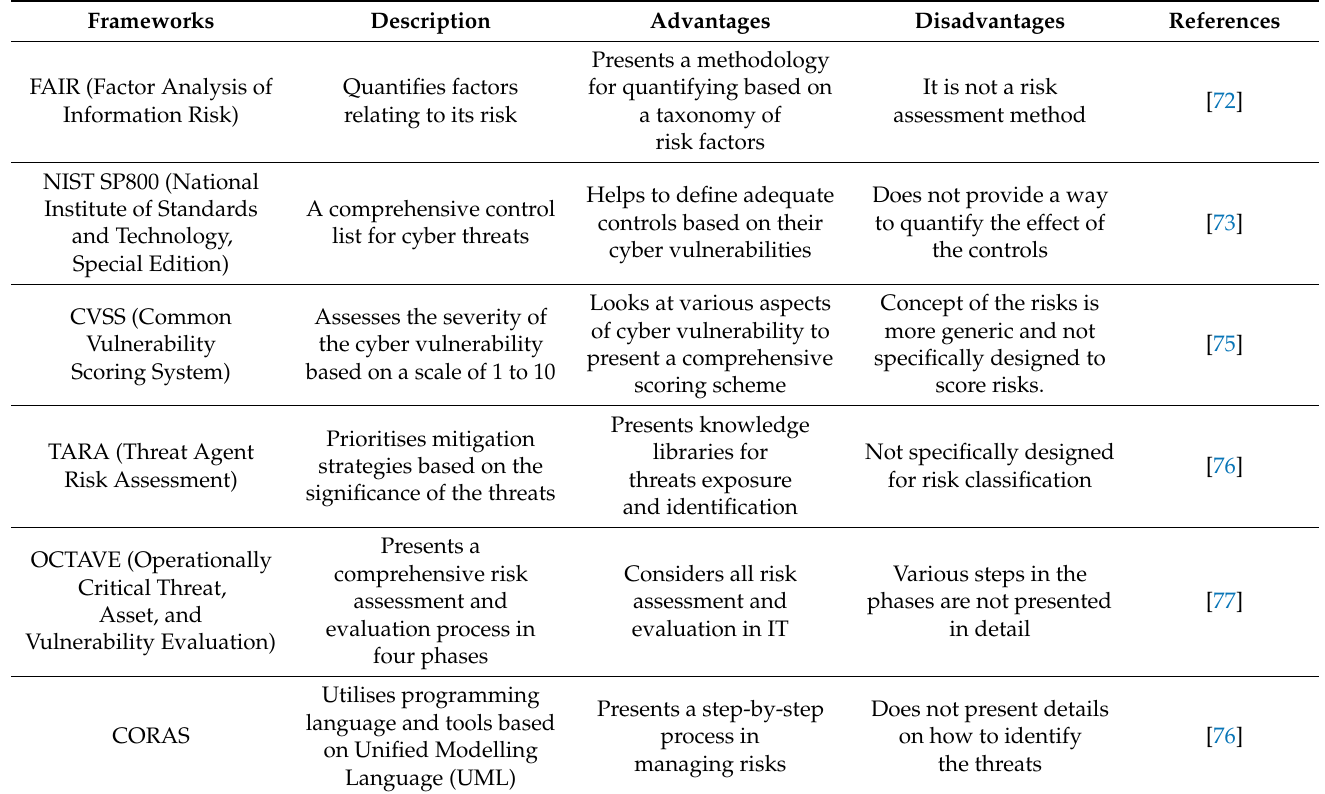
Table 2. Risk management frameworks for cyber